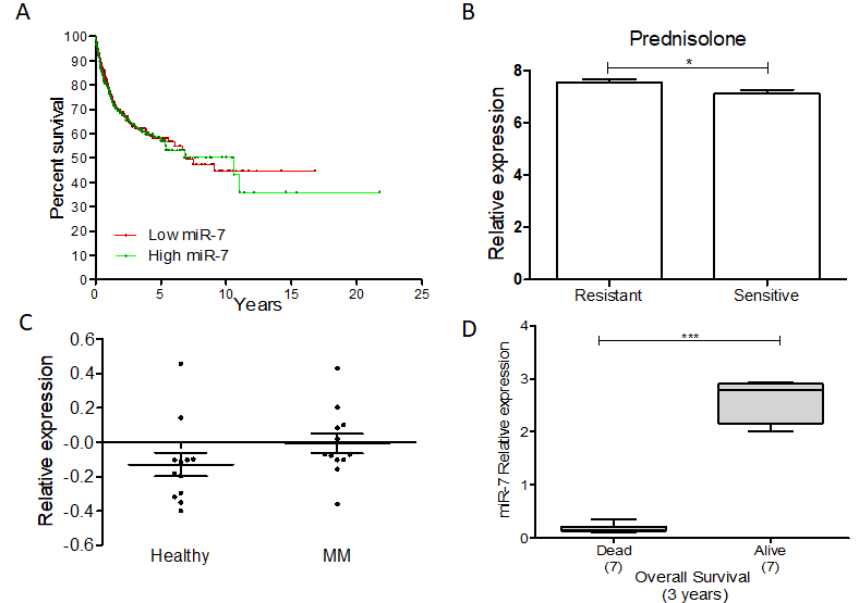
Figure 11. miR-7 and its clinical and therapeutic potential in cancer. miR-7 as a potential biomarker in some hematological malignances. ( A ) GEO database analysis expression of miR-7 in NHL. ( B ) GEO database analysis expression of miR-7 in pediatric-ALL; Student’s t test was used. ( C ) GEO analysis of miR-7 expression on MM; Student’s t test was used. ( D ) GEO database analysis expression of miR-7 in DLBCL NHL; Student’s t test was used (* p < 0.01, *** p < 0.001).